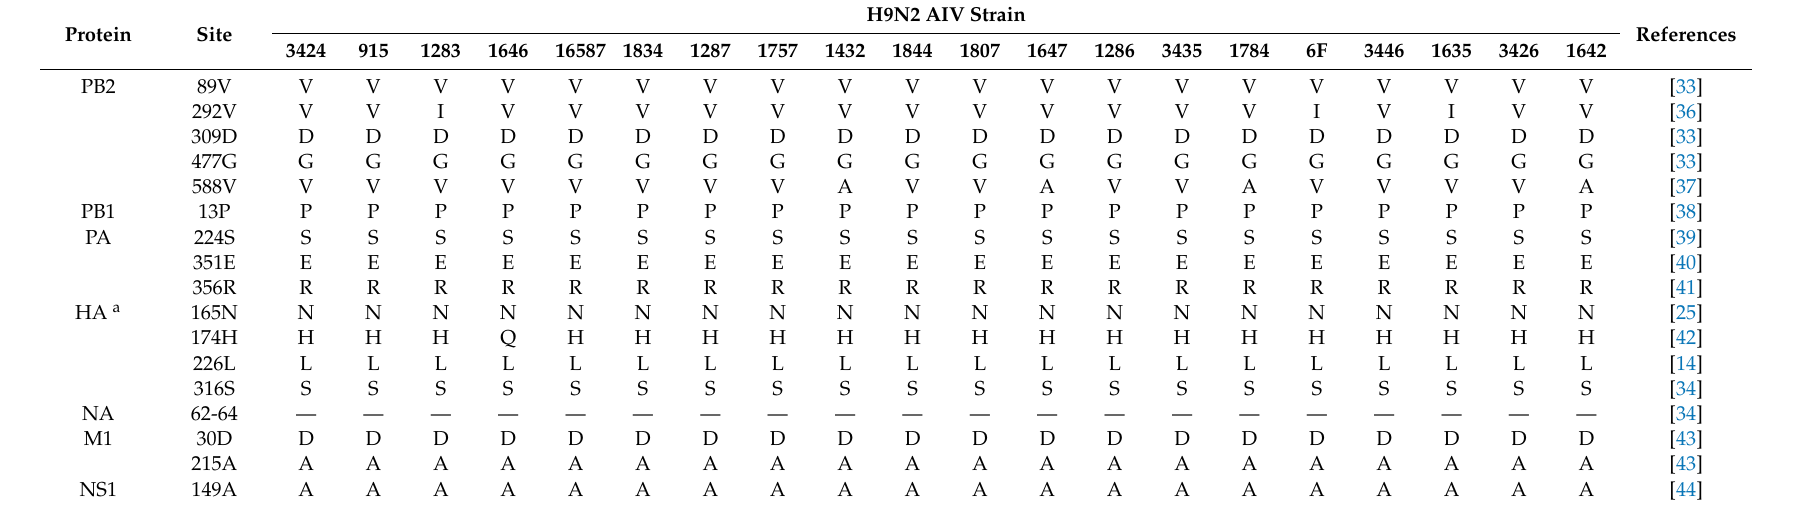
a H3 numbering. — represents deletion of amino